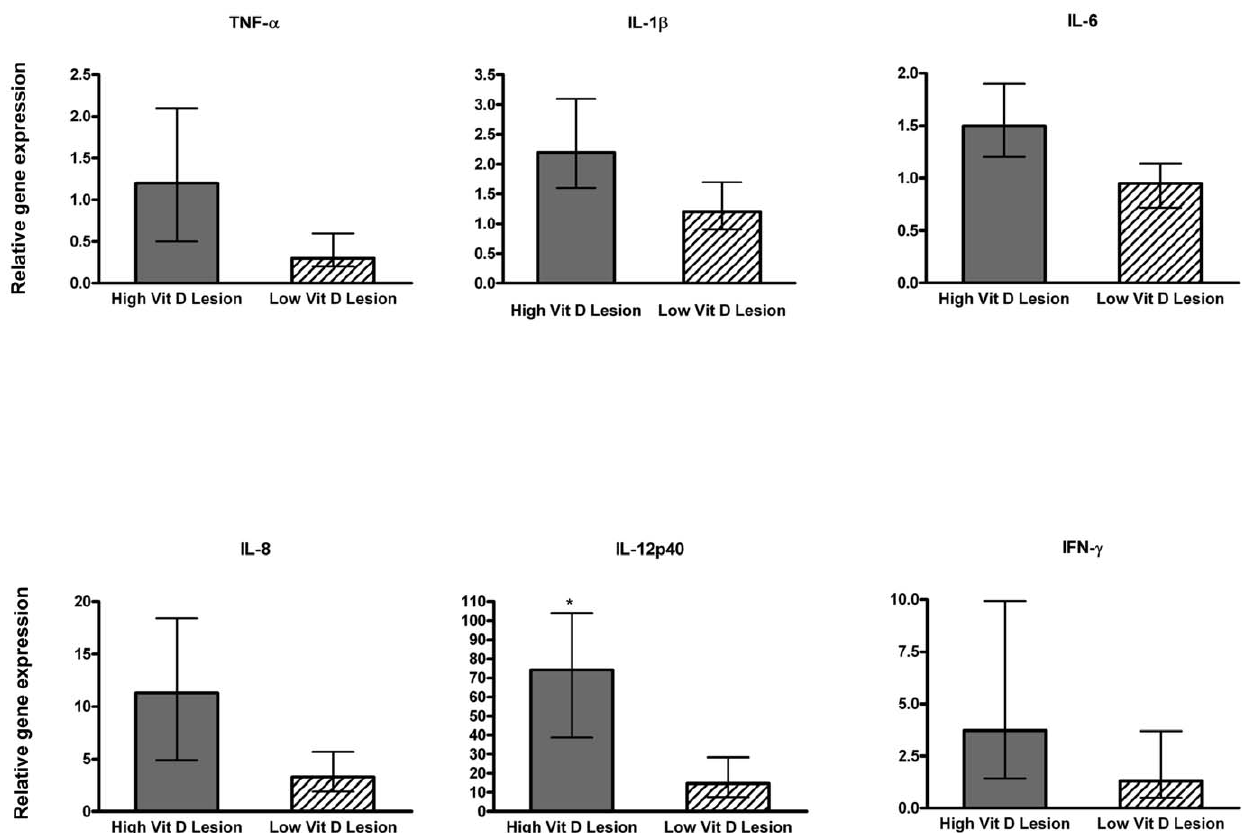
Figure 6. Pro-inflammatory cytokine gene expression levels in lesioned lung tissues of calves with high or low circulating 25(OH)D 3 following bovine RSV experimental infection. Inflammatory cytokine mRNA levels in lesioned lung samples from bovine RSV-infected calves with low (n=8) or high (n=8) circulating 25(OH)D 3 levels. The amount of each target gene was determined by quantitative real-time PCR with normalization to RPS9. DD Ct values 6 SE were transformed (2 2 DD Ct ) and data are presented as the target gene expression relative to control lung samples (n=4). Statistical analysis was performed using Student’s t-test. DD Ct values were used in the analysis of relative gene expression. *P , .05.